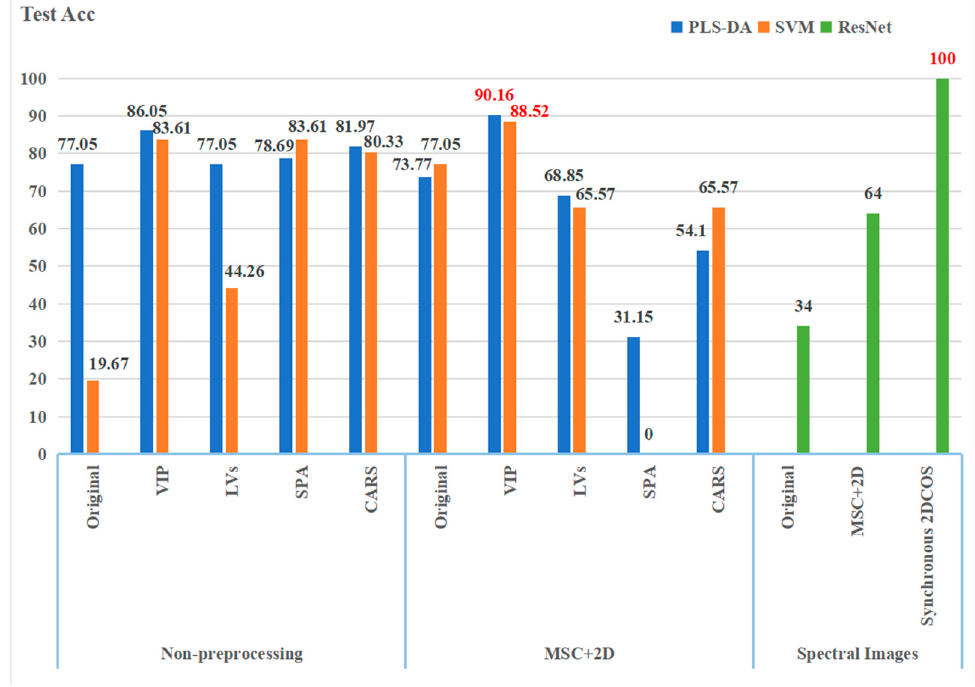
Figure 9. Comparison of PLS-DA, SVM, and ResNet models. The best results of each model are highlighted in red.